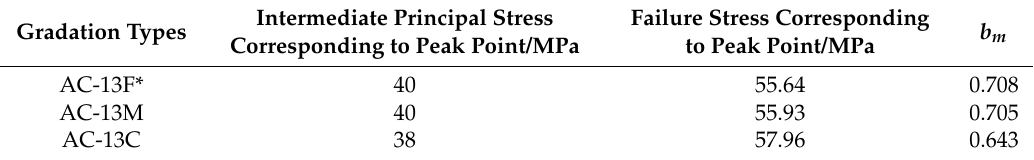
Table 3. Principal stress combination of AC-13 mixtures with different gradation.